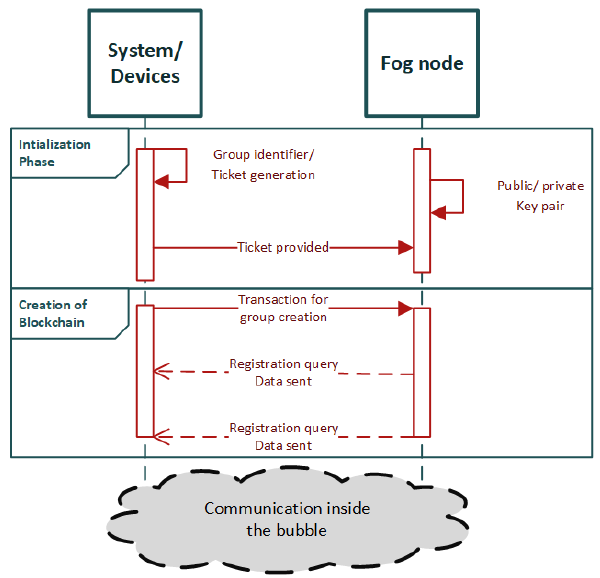
Figure 6. Sequence diagram of bubbles of trust [40].